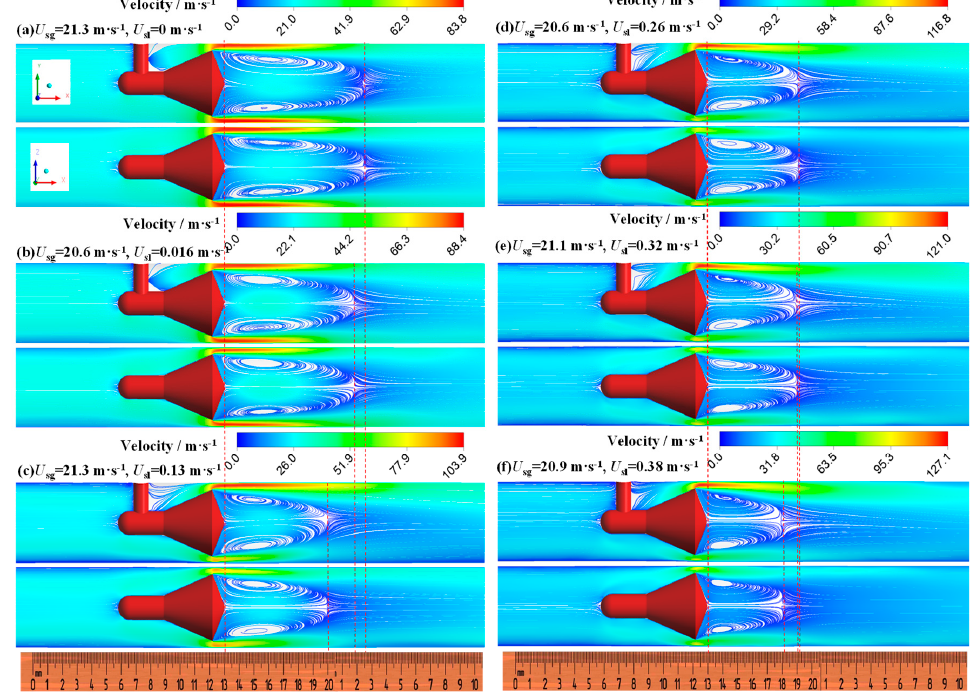
Figure 11. Effect of liquid velocity on vortex ( a ) GVF = 100%; ( b ) GVF = 99.93%; ( c ) GVF = 99.41%; ( d ) GVF = 98.77%; ( e ) GVF = 98.53%; ( f ) GVF = 98.23% (up: XOY cross section, down: XOZ cross section, ruler unit: mm).